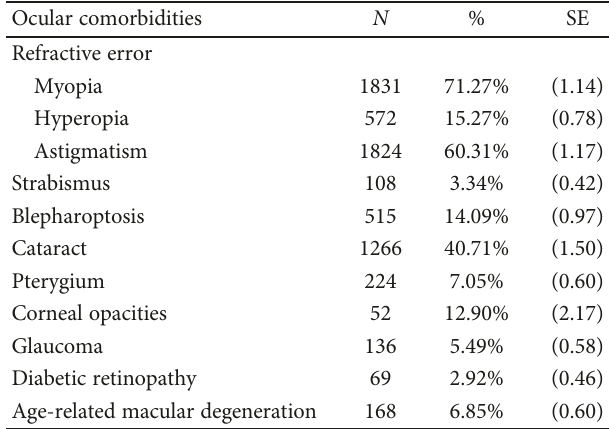
Table 1: Prevalence of ocular comorbidities in the eyes with visual impairment.